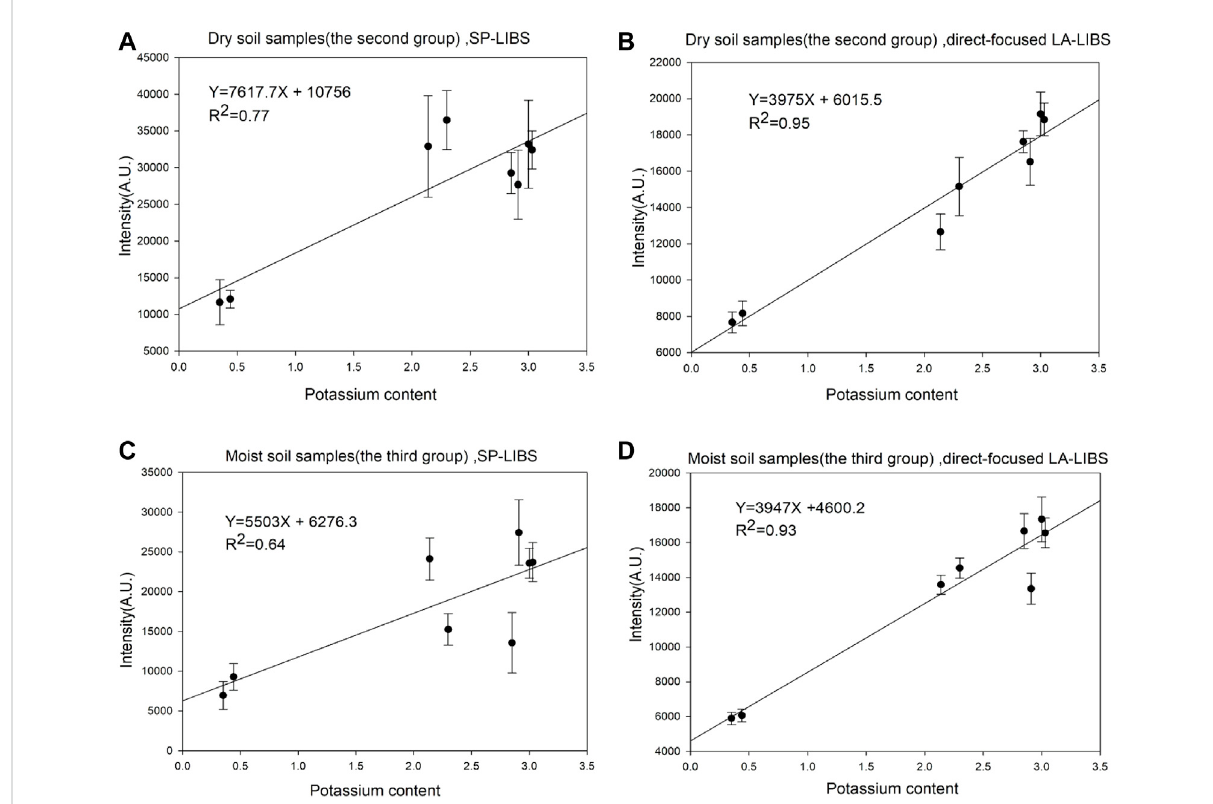
FIGURE 6 (A) The calibration curveoftheSP-LIBSfor drysoilsamples. (B) The calibration curveofthedirect-focusedLA-LIBSfor drysoilsamples. (C) The calibration curve of the SP-LIBS for moist soil samples. (D) The calibration curve of the direct-focused LA-LIBS for moist soil